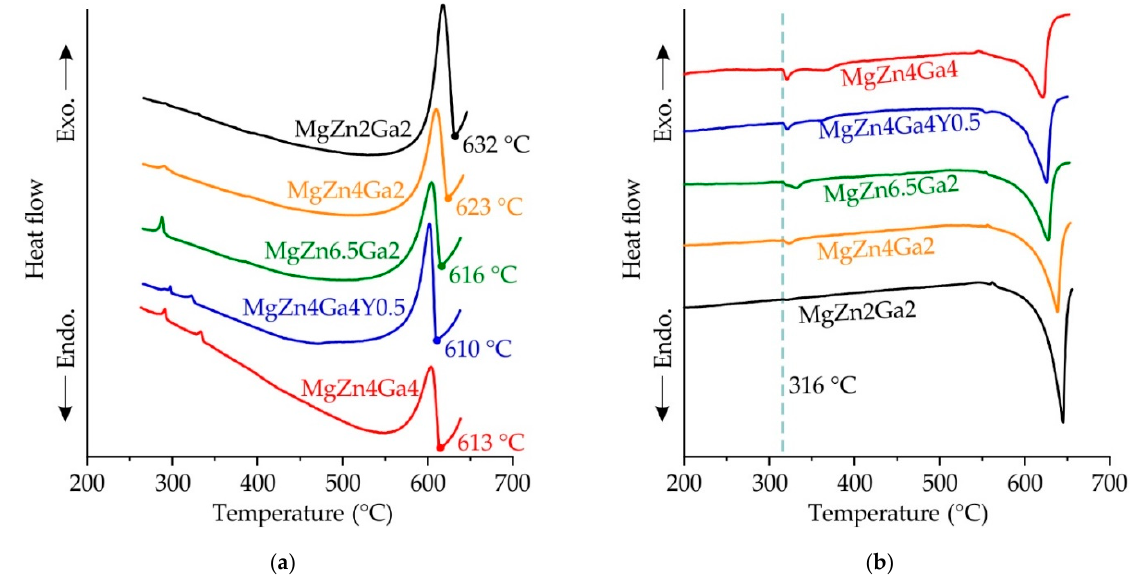
Figure 3. DSC curves of the as-cast Mg − Zn − Ga alloys: ( a ) cooling curves; ( b ) heating curves.